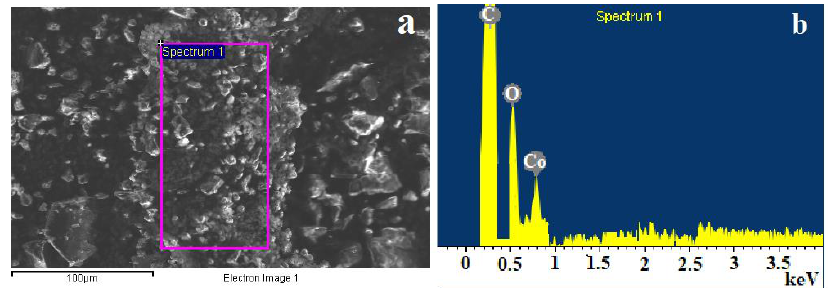
Figure 4. EDX analysis of a sample of cobalt terephthalate: ( a ) analyzed area, ( b ) EDX spectrum.